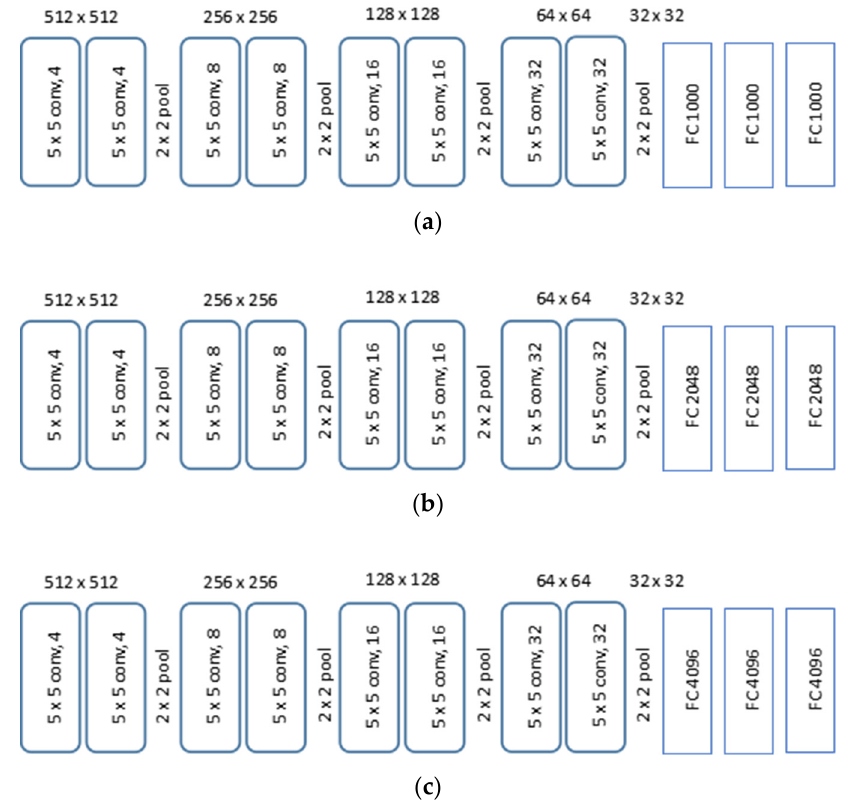
Figure 5. Structure of diffraction loss prediction CNN. ( a ) Net A; ( b ) Net B; ( c ) Net C. Two performance metrics are used to evaluate the accuracy of the neural network after training: the distribution of absolute errors and the distribution of normalized errors obtained by test data set, respectively expressed as: